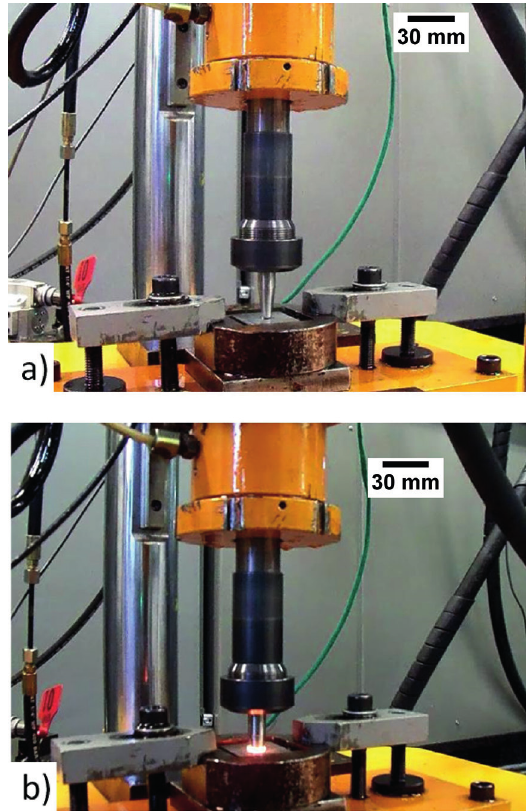
Figure 2: FHPP Processing. a) Rotating consumable plug co-axially, b) processing and pressed against